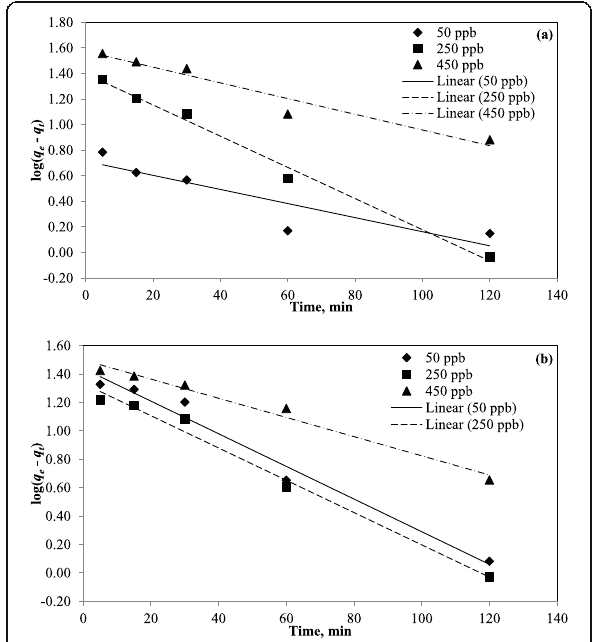
Fig. 7 Pseudo first order kinetic model for arsenate adsorption a GOFeZA and b